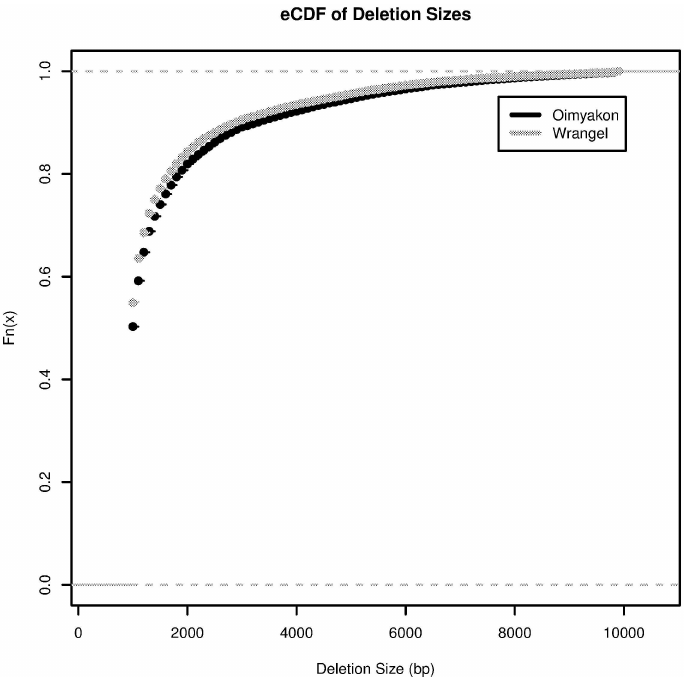
Fig 2. eCDF for the size distribution of deletions in the Oimyakon and Wrangel island genomes. There is a significantreduction in the size of deletionsidentified in the Wrangel Island